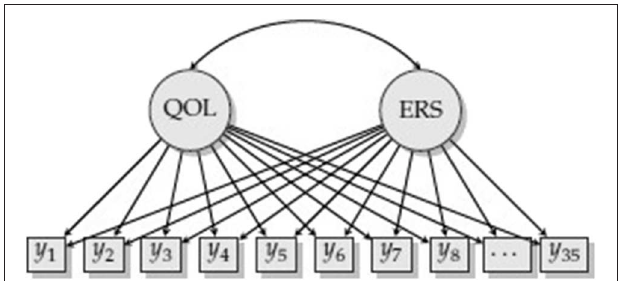
FIGURE 1 | Model with quality of life (QOL) and extreme response style